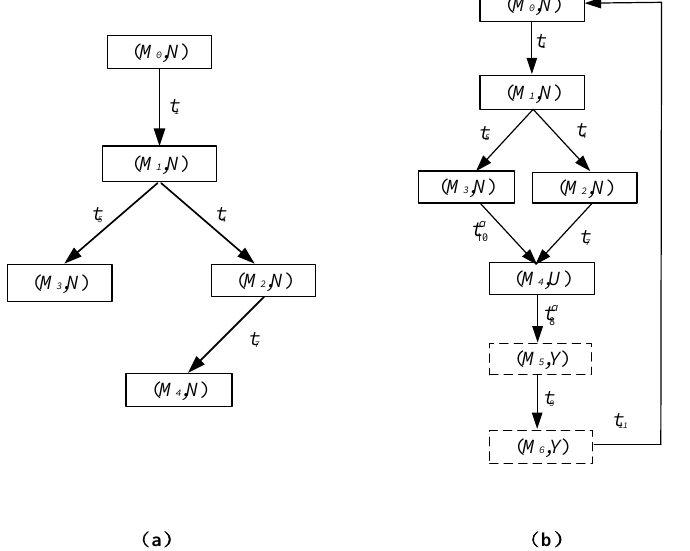
Figure 11. ( a ) The system model under normal behavior G N and ( b ) the system model under attacked behavior G F .